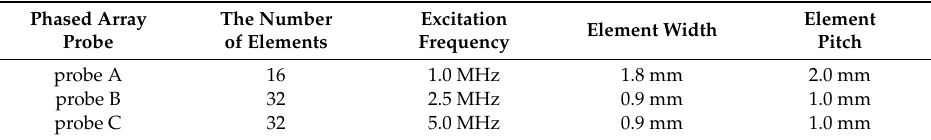
Figure 4. Rails and di ff erent phased array probes used in the experiment. ( a,c ) are diagram of the whole rail A and B respectively,( b,d ) are the relative position information of the defects in rail A and B respectively, ( e ) is the di ff erent phased array probes. Table 1. The parameters of di ff erent phased array